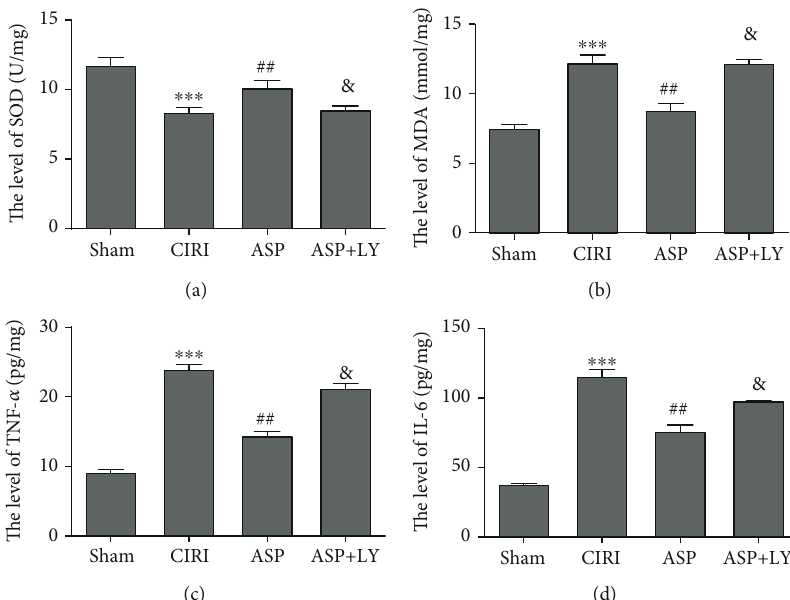
Figure 5: The e ff ect of ASP on the levels of oxidative stress and in fl ammatory cytokines in rats with cerebral ischemia reperfusion. (a) The levels of SOD. (b) The levels of MDA. (c) The levels of TNF- α . (d) The level of IL-6. Note: compared with the sham group, ∗∗∗ P < 0 : 001 ; compared with the CIRI group, ## P < 0 : 01 ; compared with the ASP group, & P < 0 : 05 . N = 10 per group.